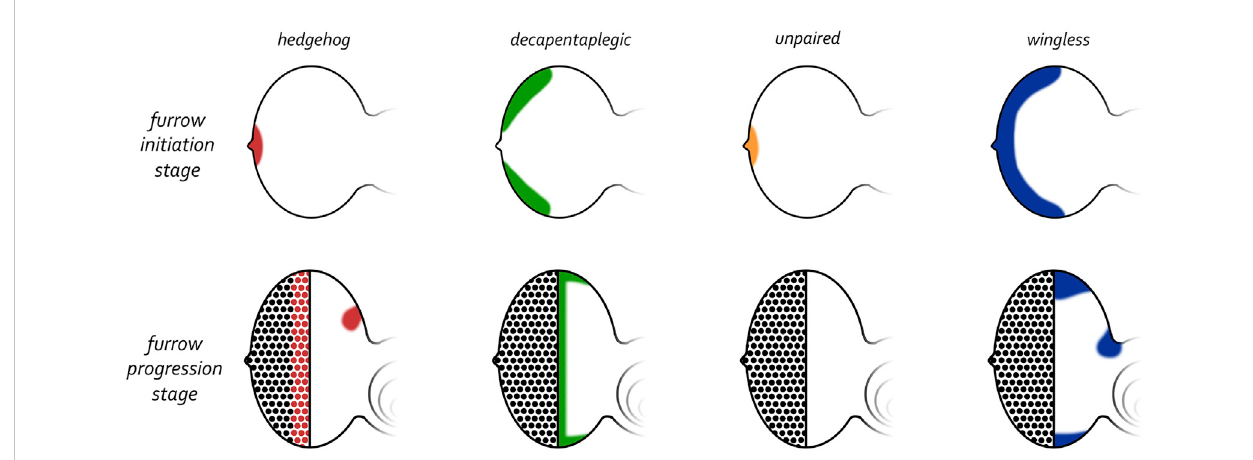
FIGURE 11 Expression patterns of morphogens that regulate patterning of the eye. (Top row) Early third larval instar just prior to the initiation of the morphogenetic furrow. Prior to the initiation of the furrow, hedgehog and unpaired are expressed at the fi ring point while decapentaplegic and wingless are along the posterior-lateral margins. (Bottom row) Mid third larval instar in which the morphogenetic furrow has progressed half-way across the eye fi eld. As the furrow progresses across the eye fi eld, the expression patterns of all four morphogens are altered dramatically. Hedgehog is expressed within the fi rst few columns of photoreceptor clusters, decapentaplegic is expressed within cells of the furrow, and wingless is expressed ahead of the furrow along the posterior margins. Both hedgehog and wingless are also expressed within the developing ocellar fi